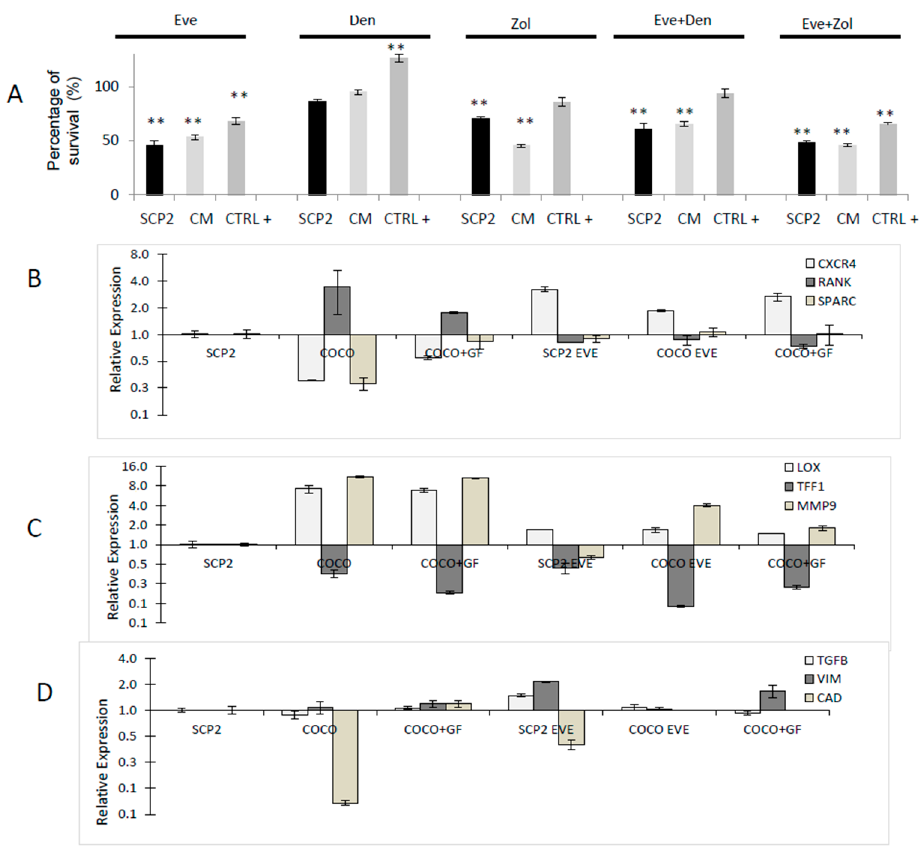
Figure 5. Drug effect on SCP2 CCs. In this case, SCP2 were indirectly co-cultured with osteoclast CM or DM as described in the Experimental section. Eve was used at a concentration of 0.1 µg/mL, Den at a concentration of 5 µg/mL, Zol at a concentration of 10 µM. ( A ) MTT analysis on cancer cells. As Anova Analysis resulted significant in all conditions (SC P2, CM, DM), Bonferroni Test was performed; in all conditions survival had significantly decreased compared to CTRL − . (** p < 0.001). Gene expression analyses on CCs cultured solely and with PBMCs. Markers of osteomimicry ( B ); CC aggressiveness ( C ); and EMT ( D ) were analyzed in presence/absence of Eve. Data were normalized with respect to untreated SCP2 cultured solely and graphed on a double logarithmic scale.